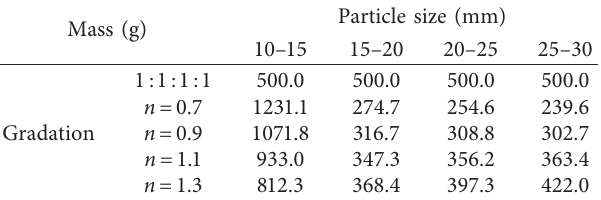
Table 1: Particle mass of different